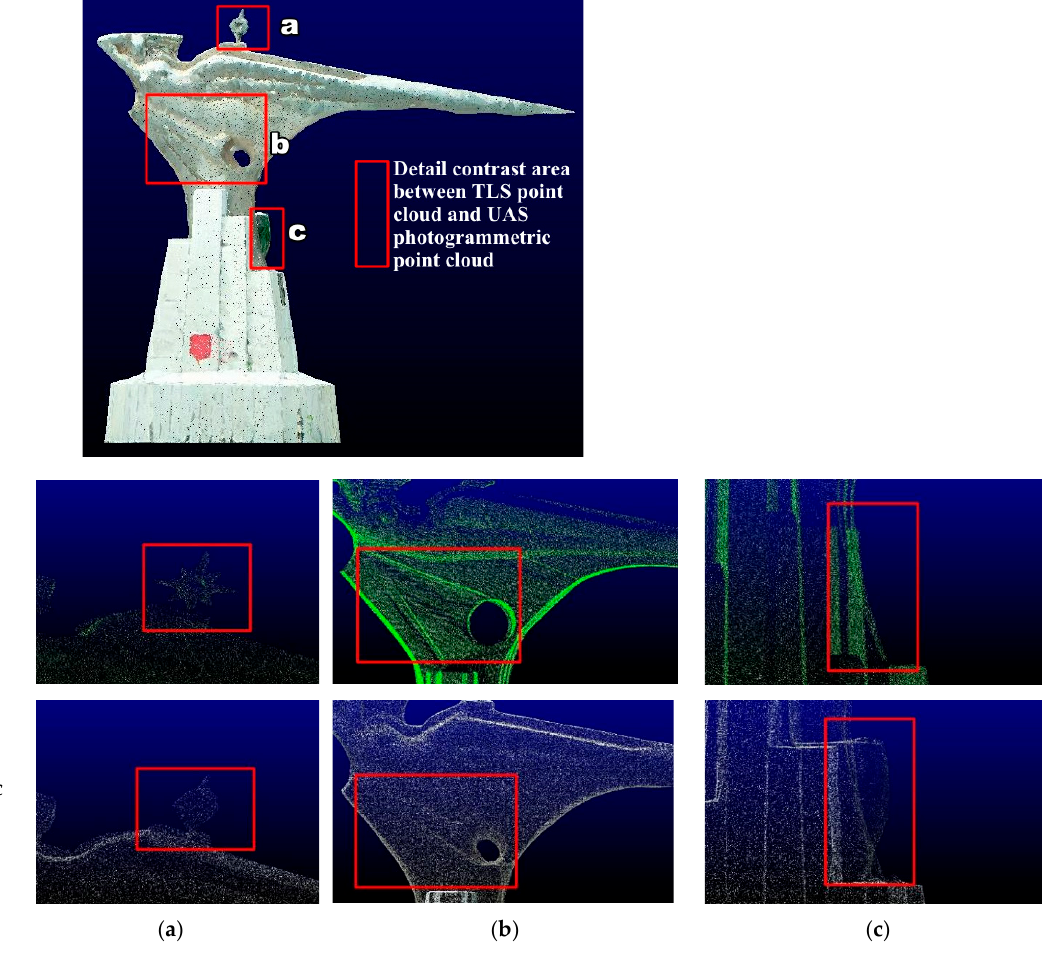
Figure 11. Comparison of TLS point cloud and UAS photogrammetric point cloud details. ( a ) Small component point cloud. ( b ) Grooved texture point cloud. ( c ) Point cloud in vegetation‑covered areas.